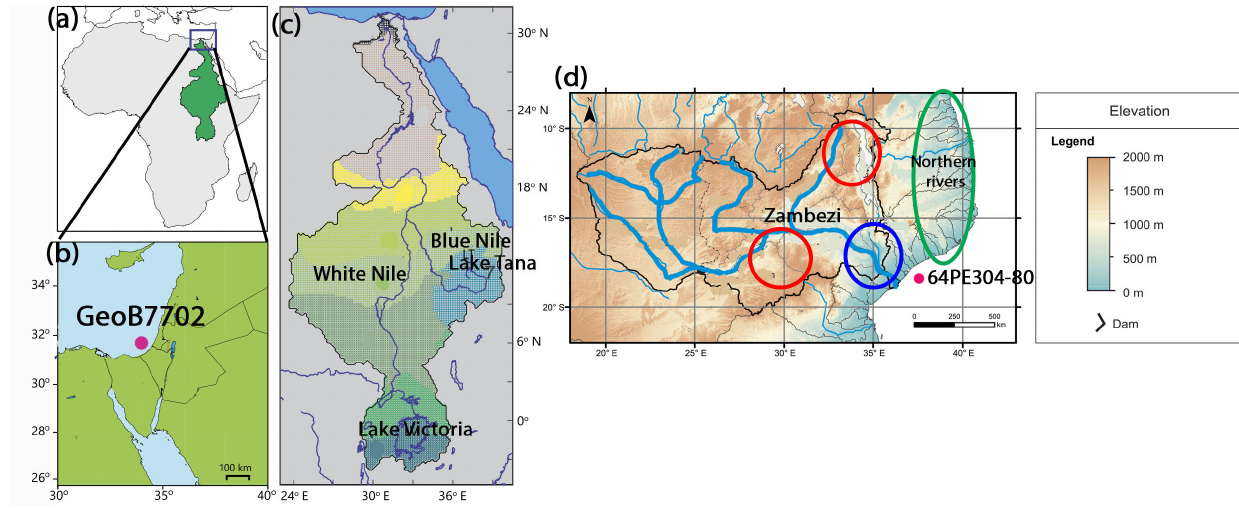
Figure 3. Sources of riverine input in both areas: (a) location of core GeoB7702-3; (b) close-up of location of core GeoB7702-3 (adapted from Castañeda et al., 2016; c ) source of the Nile river sediments (from Castañeda et al., 2016); and (d) location of core 64PE304-80 and the Mozambique Channel (red circles shows source areas of the Zambezi River during dry conditions; blue circle shows source area of the Zambezi River during wet conditions (Just et al., 2014), and green circle show northern rivers’ source area (van der Lubbe et al., 2016).